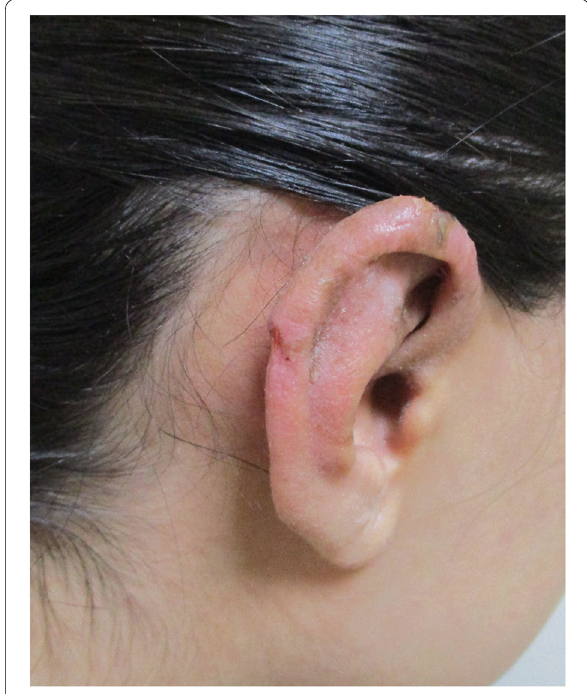
Fig. 6 Acute radiation induced side effect. Patient with G1 radiation induced acute side effect as per RTOG grading